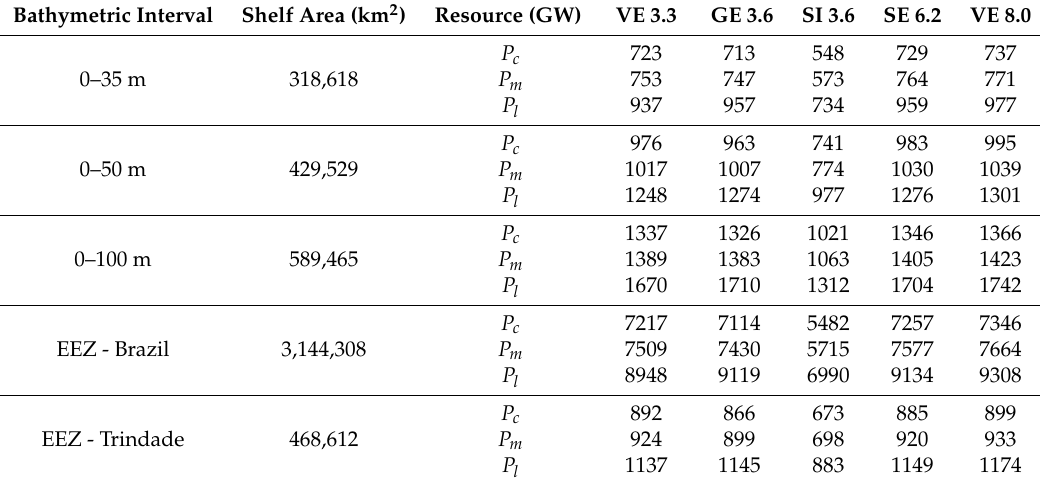
Table 2. Wind resource potential R (GW) as function of depth interval and wind turbine. Numbers refer to the average resource estimated from turbine power estimates: Monin–Obukhov ( P m ), Monin–Obukhov and density correction ( P c ) and the log-law ( P l ) methods. Bathymetric